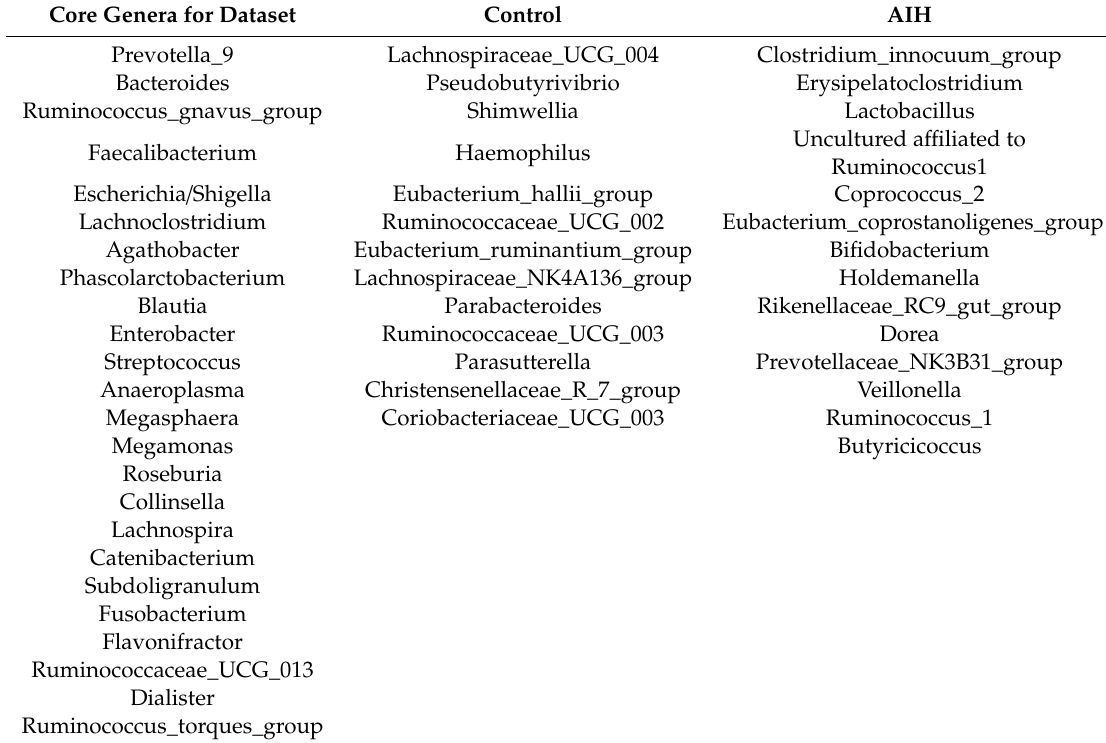
Table 2. The core and the shared genera in the entire